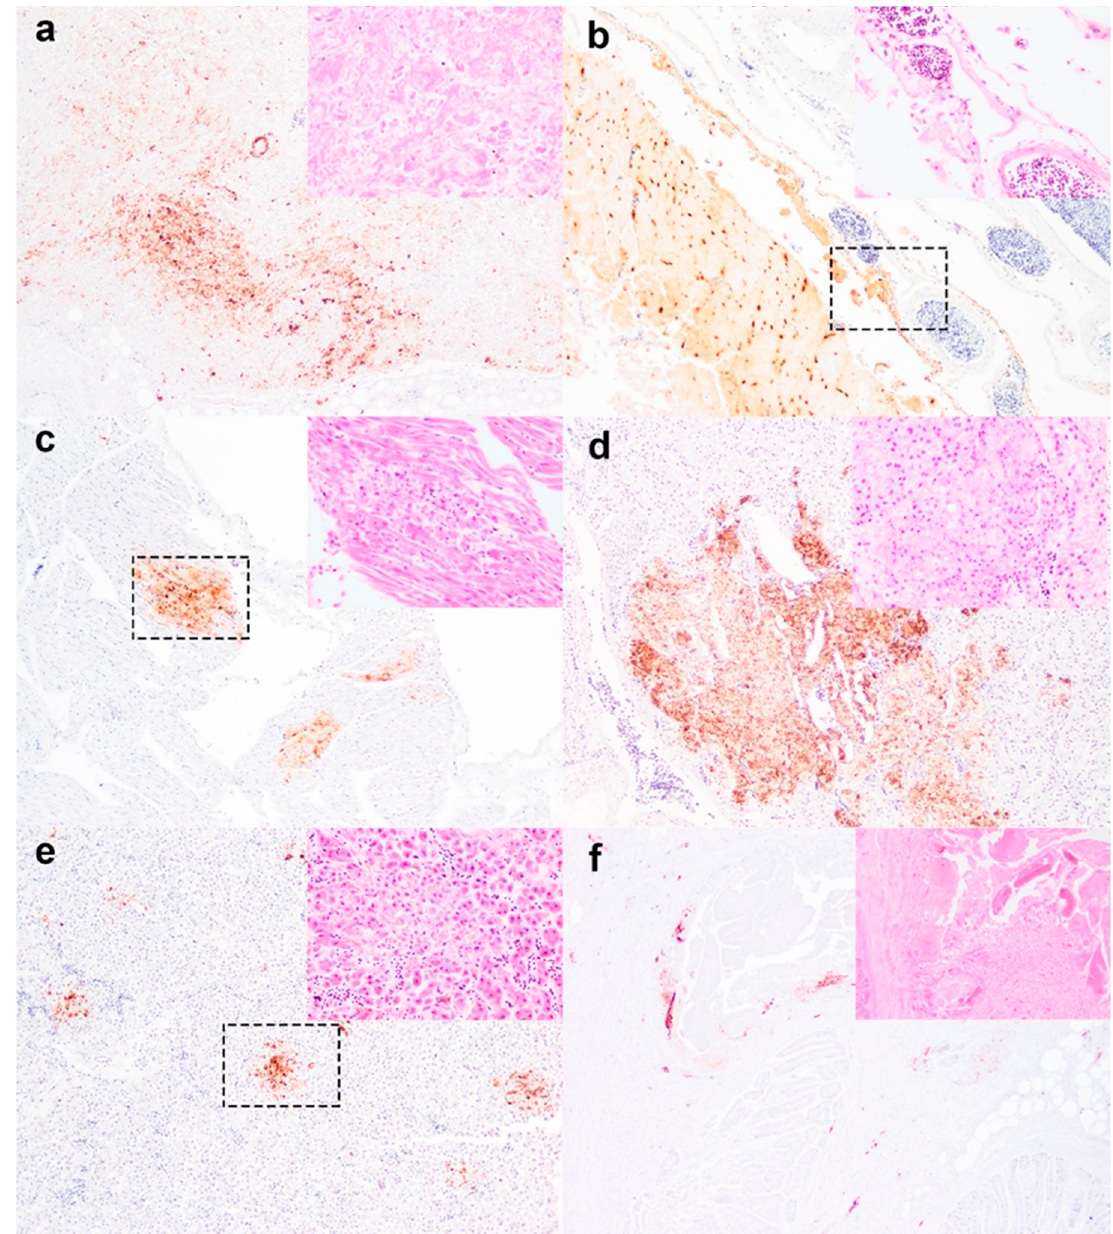
Figure 2. Microscopic findings of great skua infected with HPAIV H5N8. ( a ) Severe pancreatic necrosis with abundant virus antigens; ( b ) Mild non ‐ suppurative meningoencephalitis with confluent viral immunopositive immunolabelling; ( c ) Rare myocardial necrosis associated with scattered vi ‐ rus antigens; ( d ) Moderate adrenal necrosis with confluent virus antigen labelling; ( e ) Rare multifo ‐ cal hepatic necrosis with scattered viral immunolabelling; ( f ) A focus of glandular necrosis of the proventriculus and scattered immunolabelling within the submucosa. Region of interest within IHC images outlined by dotted line box corresponds to H&E insets. Immunohistochemical images were taken at 100× magnification. Histological images were taken at 400× magnification for a to e but 200× for the proventriculus. Genetic assessment of the virus infecting the skuas established the relationship of the H5N1 HPAI virus involved with the sequences of previous H5N1 viruses detected across the UK and Europe during the 2020/21 autumn/winter AIV season (A/great_skua/Scot ‐ land/042505/2021; A/great_skua/Scotland/B07779/2021; A/great_skua/Scot ‐ land/041672/2021) All genes clustered closely with isolates detected during the 2020/21 season with 99% nucleotide similarity with the H5N1 virus detected in pheasants